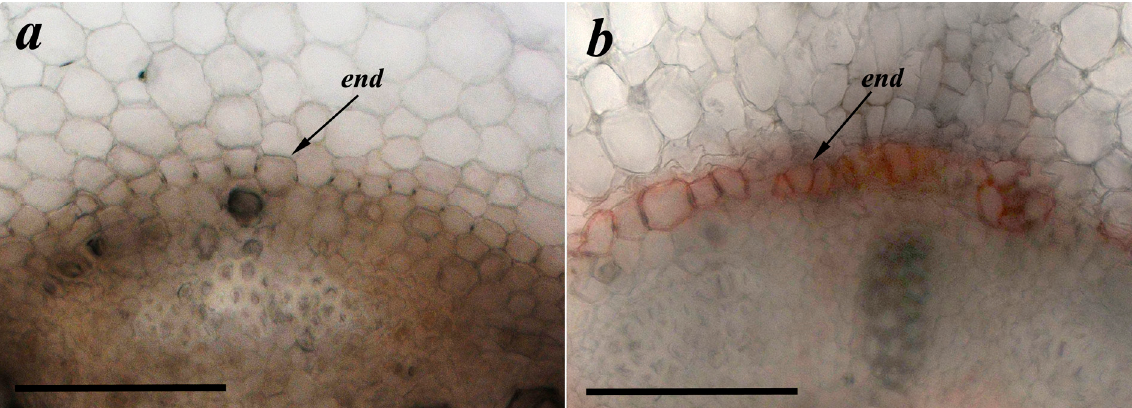
Figure 3. Effects of bacterial treatment on suberin deposition. Root cross-sections from basal part of pea roots untreated ( a ) and treated with Pseudomonas mandelii IB-Ki14 ( b ). Scale bar is 50 μ m.